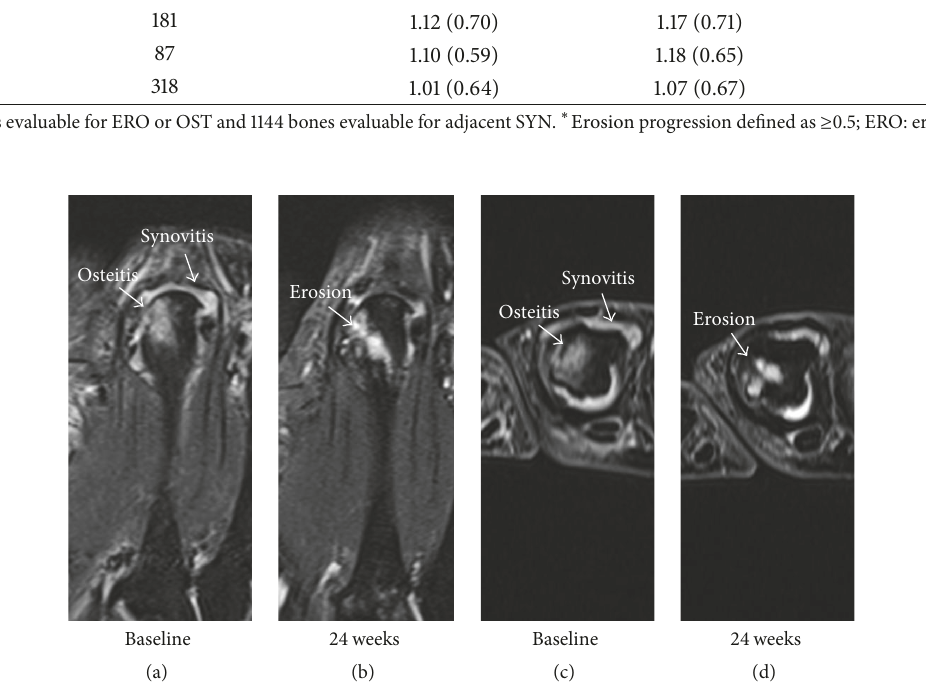
Figure 1: Baseline coronal (a) and axial (c) MR images of the second metacarpophalangeal joint show synovitis and osteitis but no erosion. At 24 weeks (c, d) the synovitis has decreased, and the osteitis has converted to erosion. Cartilage loss had also developed in this joint at 24 weeks (better seen on an adjacent MRI slice not shown). Without an additional time point prior to 24 weeks, however, it is not possible to determine whether the erosion developed prior to the decrease in inflammation or despite it. Further, without a time point after 24 weeks, it is not possible to determine whether the degree of residual synovitis present at 24 weeks is sufficient to drive further progression in joint damage in this